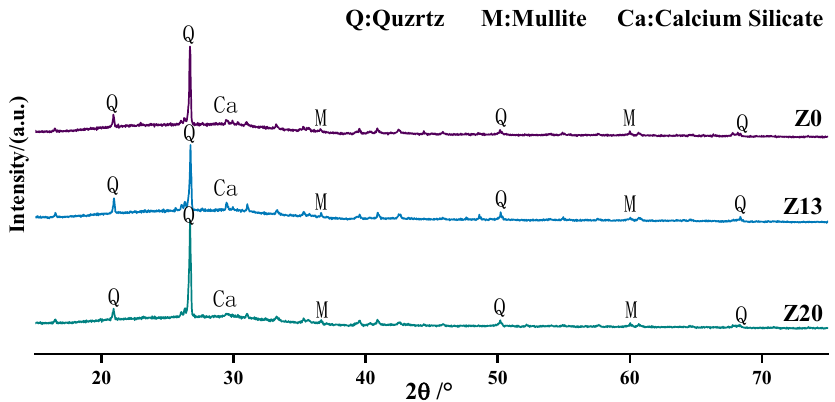
Figure 10. XRD patterns of geopolymers with different mixing ratios.